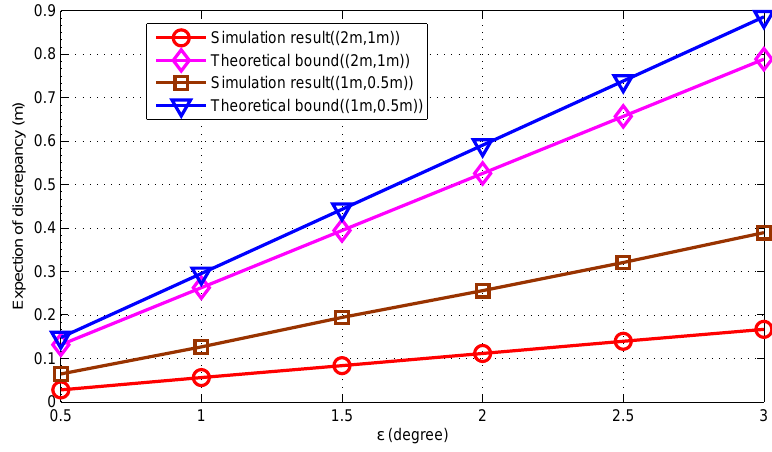
Figure 9. Performance analysis versus mobile device position.